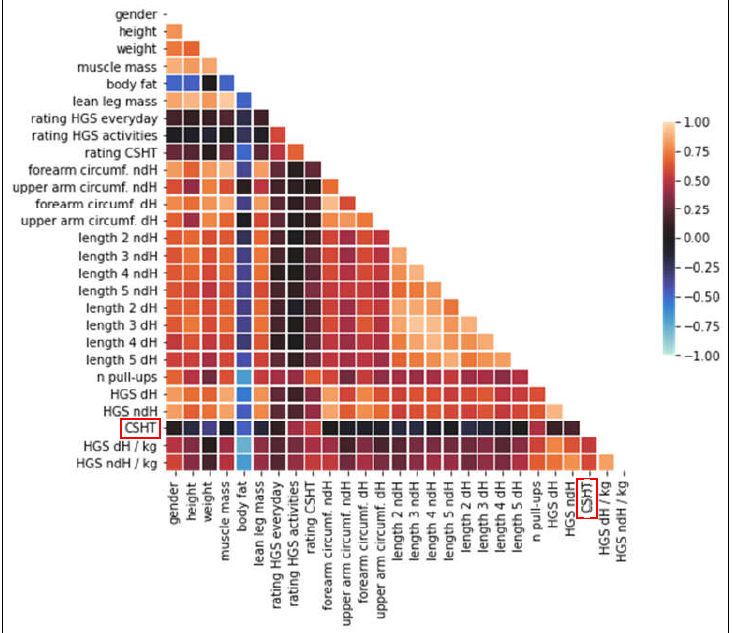
Figure 2. Descriptive correlation heat map of the measured variables. The color saturation represents the correlation strength (blue = negative correlation, yellow = positive correlation). The maximal climbing-specific holding time (CSHT) is highlighted with red boxes.